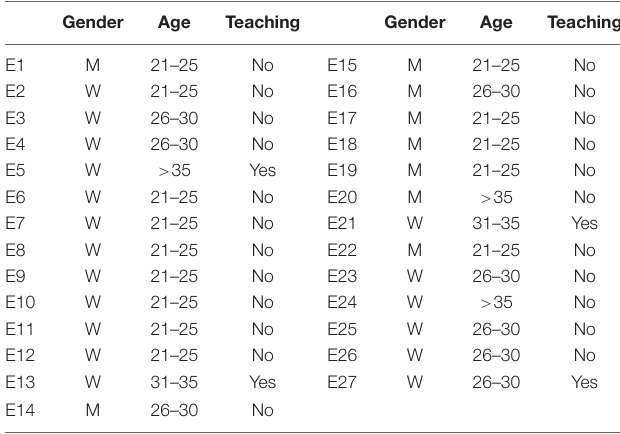
TABLE 1 | Characteristics of the sample